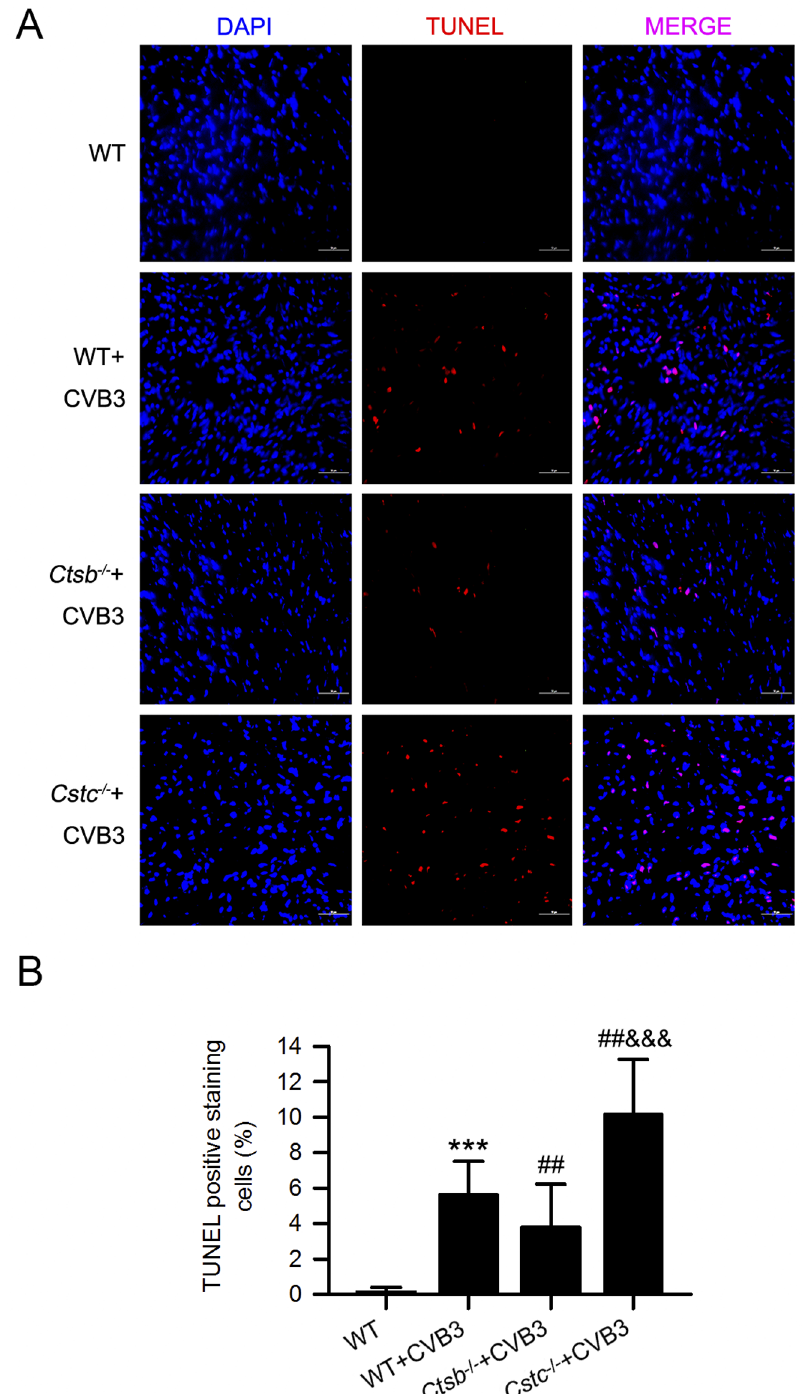
Fig 6. CatB deficiency reduced while cystatin C deficiency increased myocardial pyroptosis caused by CVB3 inoculation. (A) Representative cardiac TUNEL staining of mice with different treatments. Scale bar: 50 μ m. (B) The statistical result showed the increased TUNEL positive staining cells in the WT+CVB3 group were significantly decreased in the Ctsb -/- +CVB3 group, but further increased in the Cstc -/- +CVB3 group. (WT group: n = 10; WT+CVB3 group: n = 14; Ctsb -/- +CVB3 group: n = 12; Cstc -/- +CVB3 group: n = 11; (cid:3)(cid:3)(cid:3) P < 0.001 vs . WT group; ##P < 0.01 vs . WT +CVB3 group; &&&P < 0.001 vs . Ctsb -/- +CVB3 group).